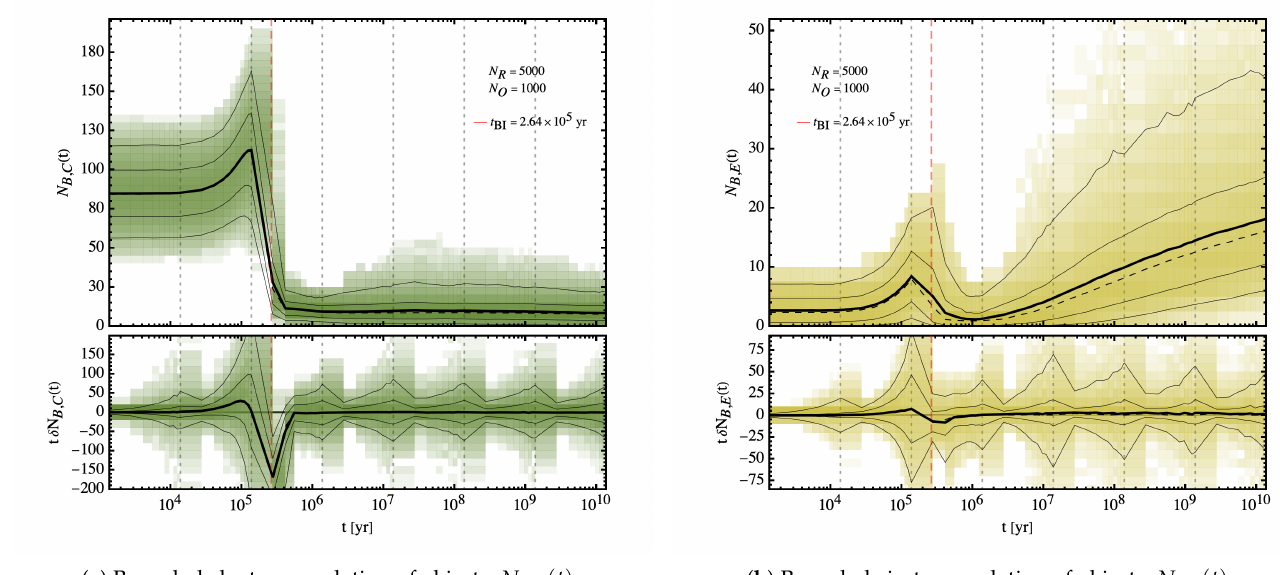
Figure 9. Top: Total population of bounded in-cluster and in-ejecta objects in green and yellow, N B, X ( t ) where X = C,E. The thick black line mark to the mean of the discrete distribution of evolution trajectories per snapshot, while the thin black line represents the median. Bottom: Differential of the total population of bounded in-cluster/in-ejecta objects, or loss/gain counts in between snapshots, rescaled by the simulation time, t δ N B, X ( t ) , where X = C,E. The thick black line marks the mean differential counts, while the thin black line represents the median differential counts. The dotted black line corresponds the B i coefficient of the logarithmic decrease/increase, or alternatively, the mean differential counts themselves. All: The darker and lighter regions represent the 68% and 95% C.B. of each individual evolution of the cluster and ejecta populations for all N R = 5000 realisations. The dotted vertical grey lines separate the N r = 7 consecutive runs, and the dotted vertical grey line signals the burn-in time. The population’s evolution is fitted to PLs in Table